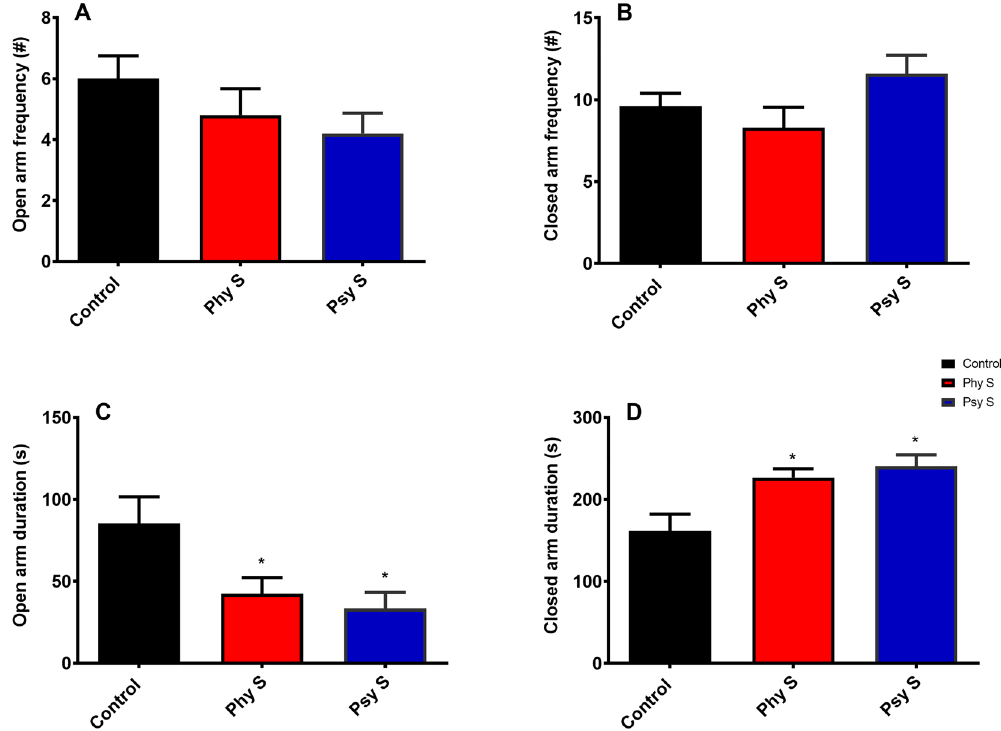
Figure 3. Assessment of the effect of PS on anxiety-like behavior of the offspring in EPM. ( A , B ) Frequency of entries into open and closed arms. ( C , D ) Time spent in open and closed arms. Data are displayed as Mean ± SEM. Phy s: physical stress, Psy s: psychological stress, * ( p < 0.05) compared to the control